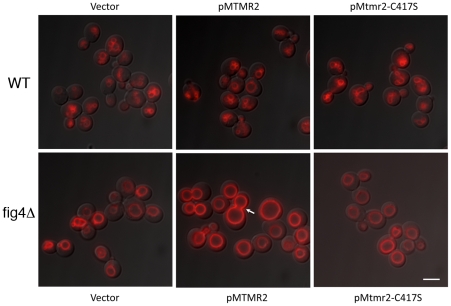
MTMR2 and FIG4 interaction in yeast.Expression of human FLAG-MTMR2 in the mutant yeast strain fig4Δ, caused enlarged vacuoles and a defect in vacuole fission. Wild-type and fig4Δ expressing pVT102U (vector), pVT102U-MTMR2 or pVT102U-MTMR2-C417S, were grown to mid-log phase and the vacuole membrane was labeled with SynaptoRed C2. Arrow indicates an example of a bud vacuole that has not properly separated from the mother vacuole. Scale bar, 6 µm.